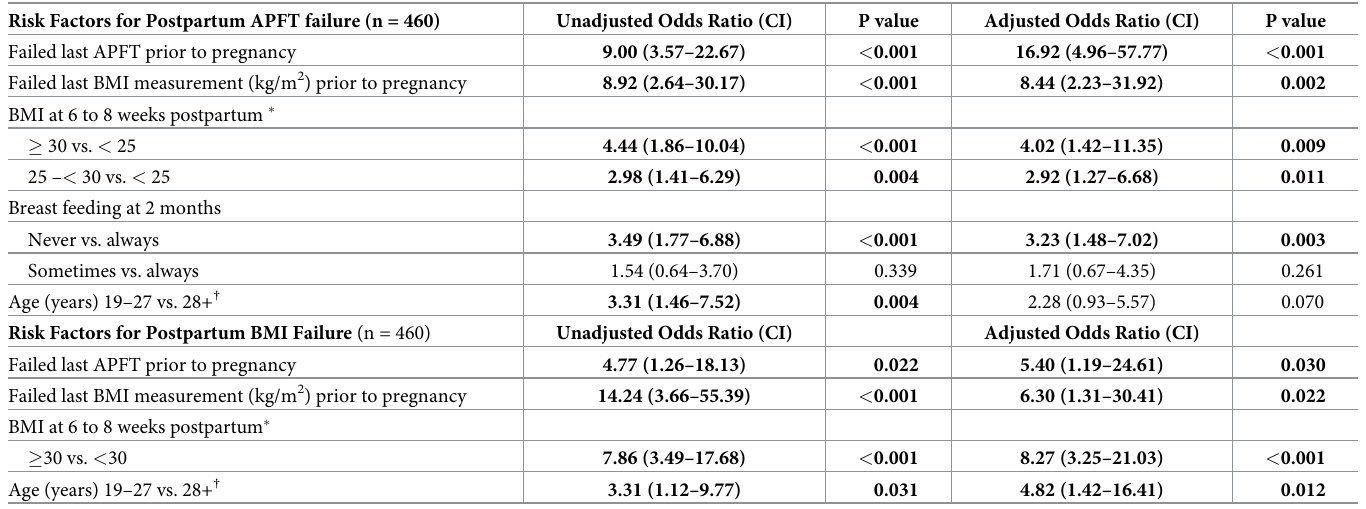
Table 5. Adjusted odds ratio for risk factors of postpartum APFT and body composition failure with imputed